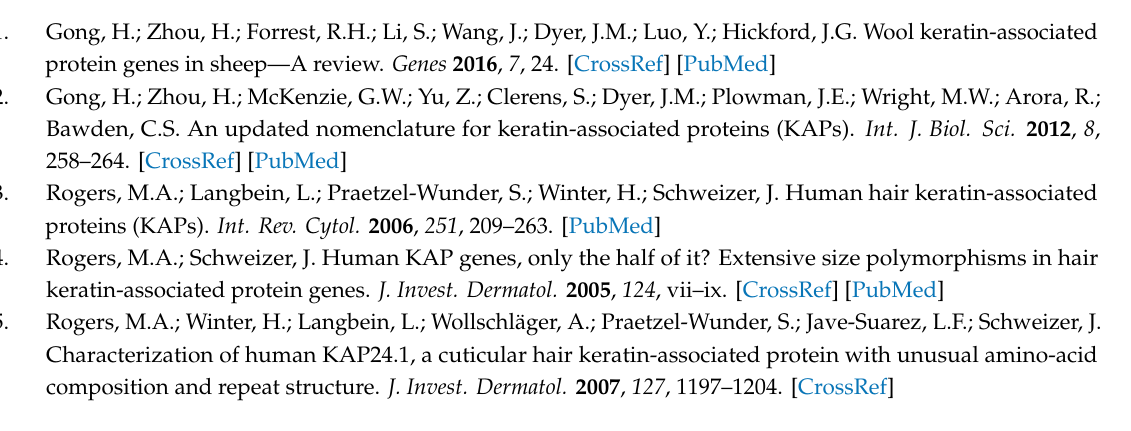
Figure S1. Comparison of the predicated amino acid sequences of the newly identified ovine KAP28-1 gene and other similar KAP